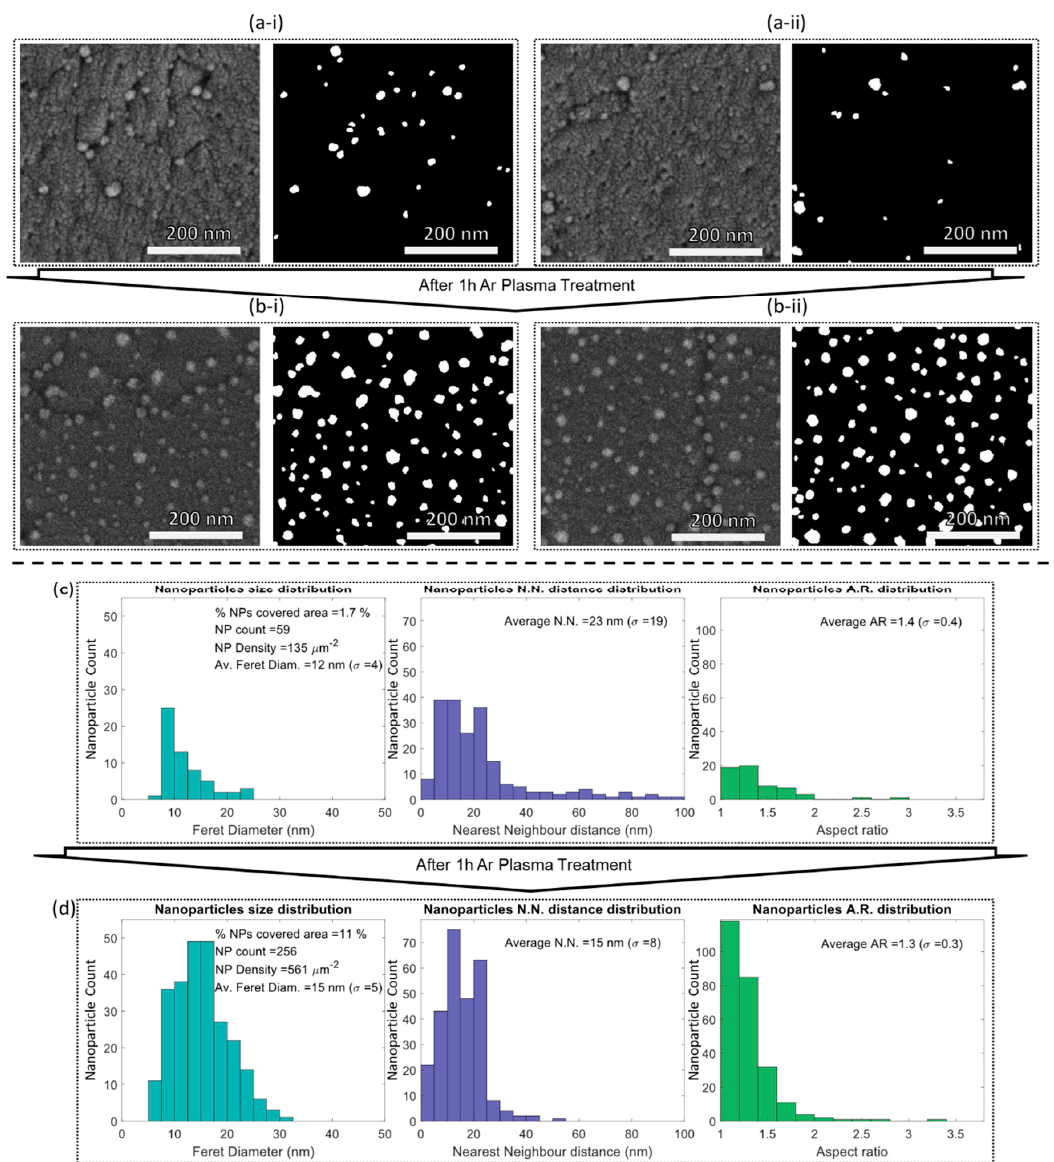
Figure 2. SEM top-view micrographs in two different areas of the film’s surface, before ( a-i , a-ii ) and after ( b-i , a-ii ) the “uncovering” of the Au nanoparticles by plasma treatment. Statistical analysis of the exposed nanoparticles (size, nearest neighbor, and aspect ratio distributions) before ( c ) and after ( d ) plasma treatment.